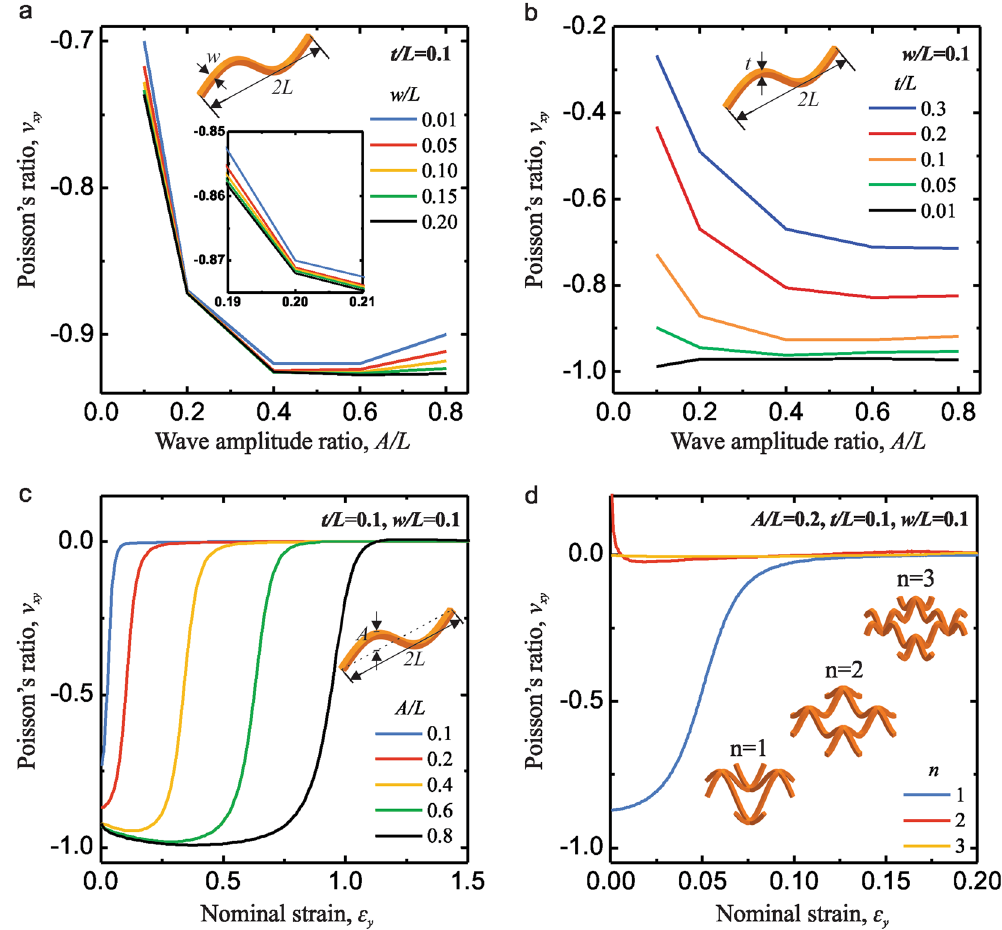
Figure 5. Effect of A/L , w/L , t/L , and n on the macroscopic Poisson’s ratio of the 3D planar metamaterials, ν yx . Evolution of ν yx as a function of A/L is shown in ( a ) for five different values of w/L (assuming t/L = 0.1), in ( b ) for five different values of t/L (assuming w/L = 0.1). Evolution of ν yx as a function of nominal strain is shown in ( c ) for five different values of A/L (assuming t/L = 0.1 and w/L = 0.1), and in ( d ) for three different values of n (assuming A/L = 0.2, t/L = 0.1 and w/L =